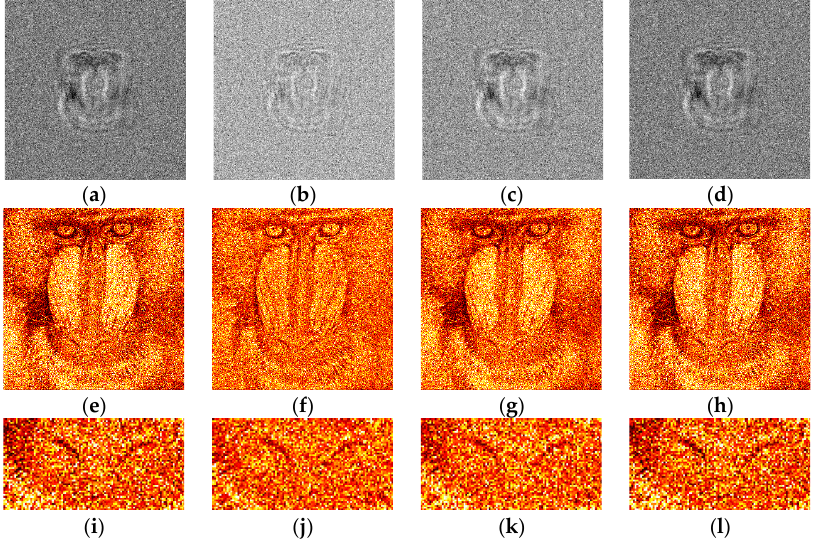
Figure 2. Examples of synthesized binary inline Fresnel holograms containing the “Baboon” image, corresponding reconstructed images and their enlarged fragments. Holograms were binarized using the Otsu ( a , e , i ), Sauvola ( b , f , j ), Li ( c , g , k ), and Huang ( d , h , l ) methods.